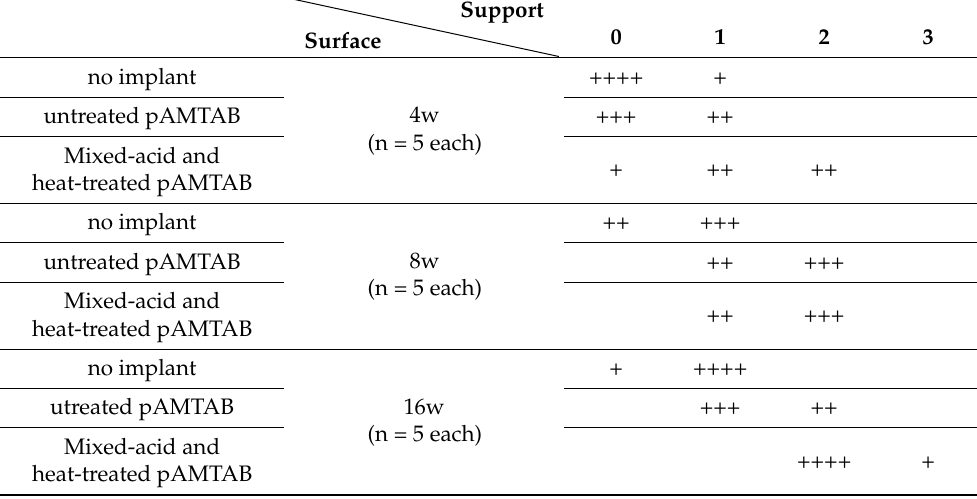
Table 1. Evaluation of bone formation in each group: In the no implant control group, no individual rats showed any bone formation exceeding a score of 1 at any time point, but in the porous additive- manufacturing titanium artificial bone (pAMTAB) groups, bone formation exceeding a score of 2 was observed in both the untreated pAMTAB and mixed-acid and heat-treated pAMTAB groups. Support 0 1 2 3 Surface no implant ++++ + 4w untreated pAMTAB +++ ++ (n = 5 each)